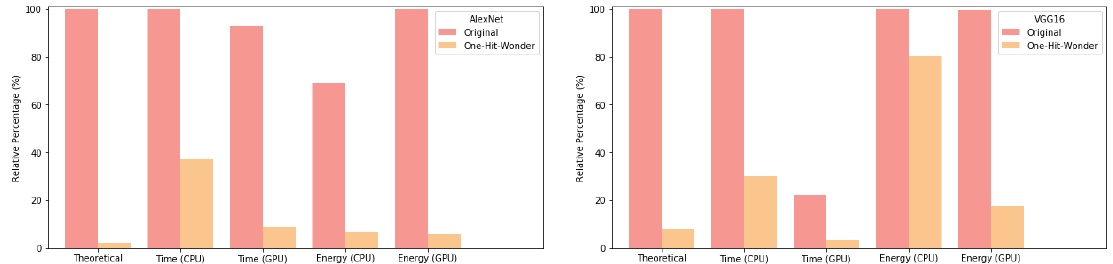
Figure 4. Barcharts for AlexNet and VGG16, illustrating the difference between the theoretical, CPU and GPU efficiency with respect to their computational speed and energy consumed on the MIT67